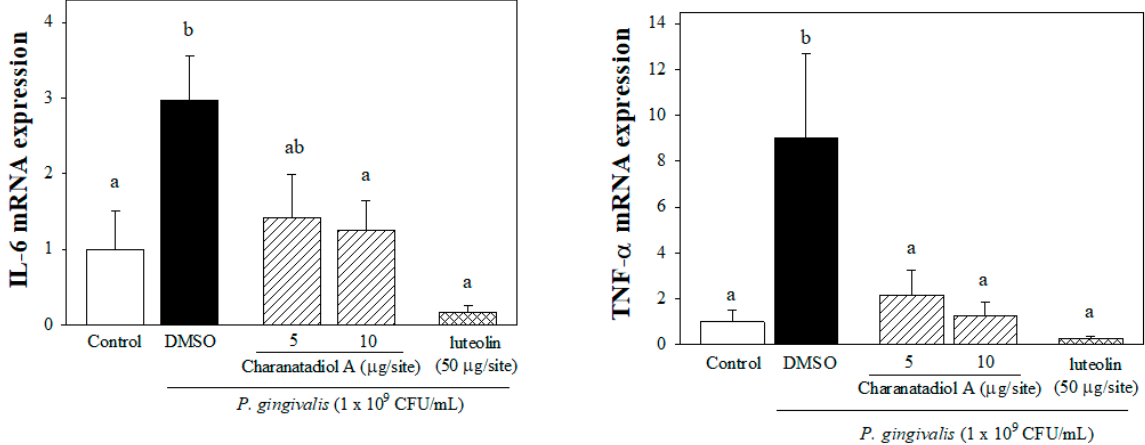
Figure 5. Charantadiol A suppressed pro-inflammatory cytokine mRNA expressions in P. gingivalis -stimulated gingival tissue of mice. Each value shows the mean ± SD. Values with different letters are significantly different at p < 0.05.